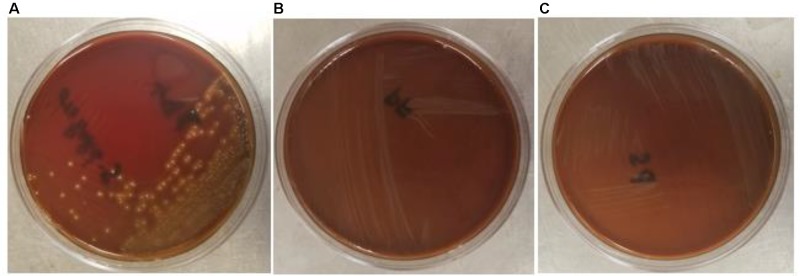
(A–C) Hemolytic activity of Streptococcus pyogenes, P. freudenreichii (PF) and P. shermanii (PS). PF or PS cultures (109 CFU ml−1) were streaked on Columbia turkey blood agar. Columbia turkey blood agar streaked with S. pyogenes with known hemolytic activity was kept as positive control (n = 6; P < 0.05).